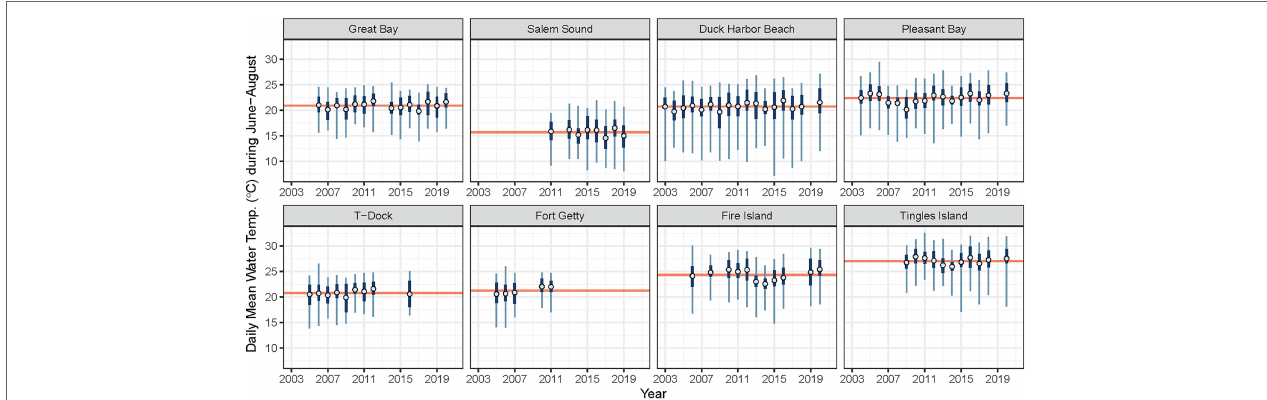
FIGURE 3 | Average daily mean water temperature during June-August each year (blue open circle) for associated years in which eelgrass cover was surveyed. Interquartile range and range of observed daily mean water temperatures are plotted in dark and light blue, respectively. The time period average (mean of all daily means) is plotted as horizontal red line. Water temperature data were not available for all years at all sites. Displayed here are only the temperature records used in the analysis.